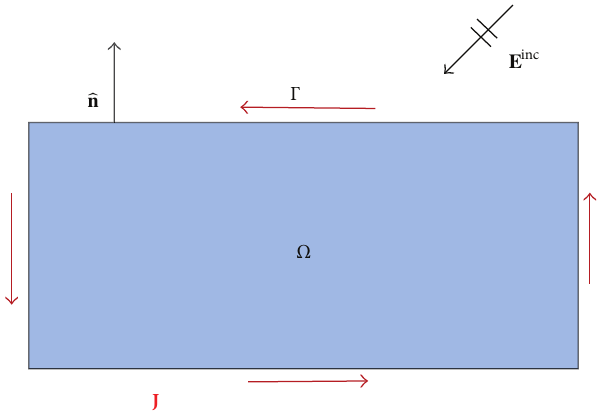
Figure 1: EM scattering from a PEC object.